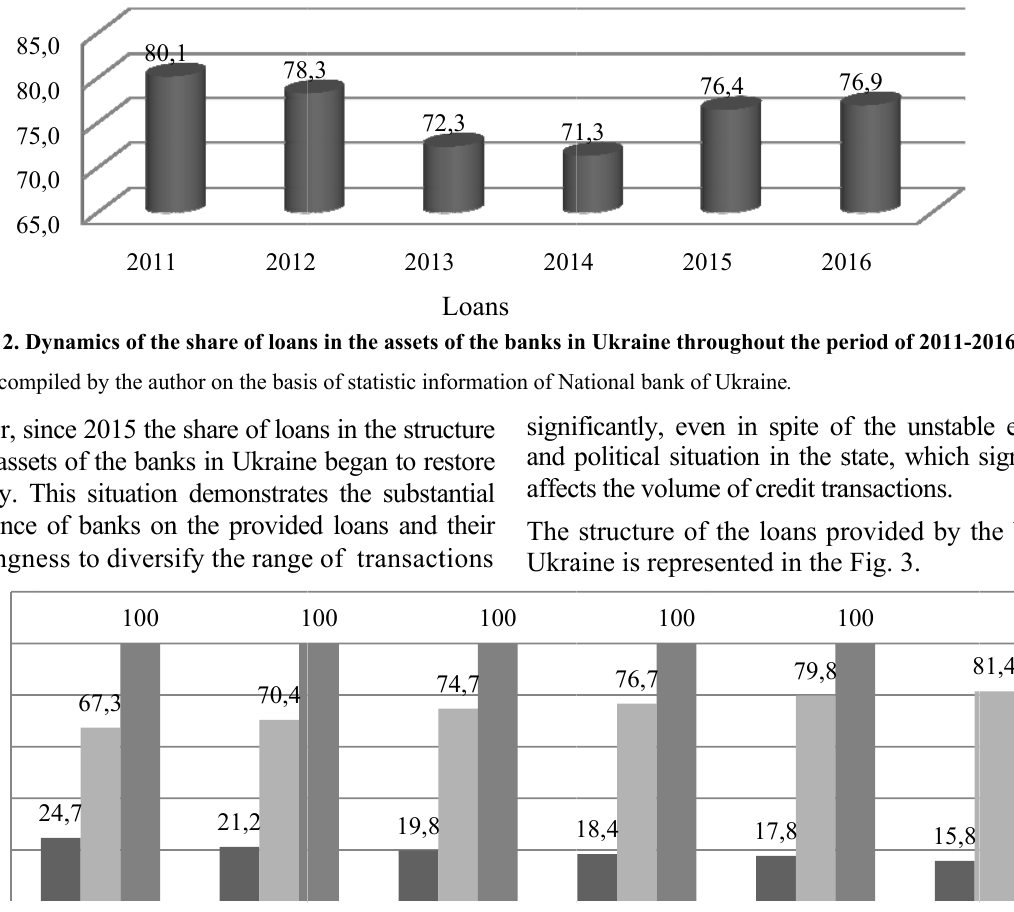
2 oans in Ukraine vided eased loans Thus tities value 1.4% ivate with value ge in erate n and ks in ders- lend- r the pport. nsol- ne of